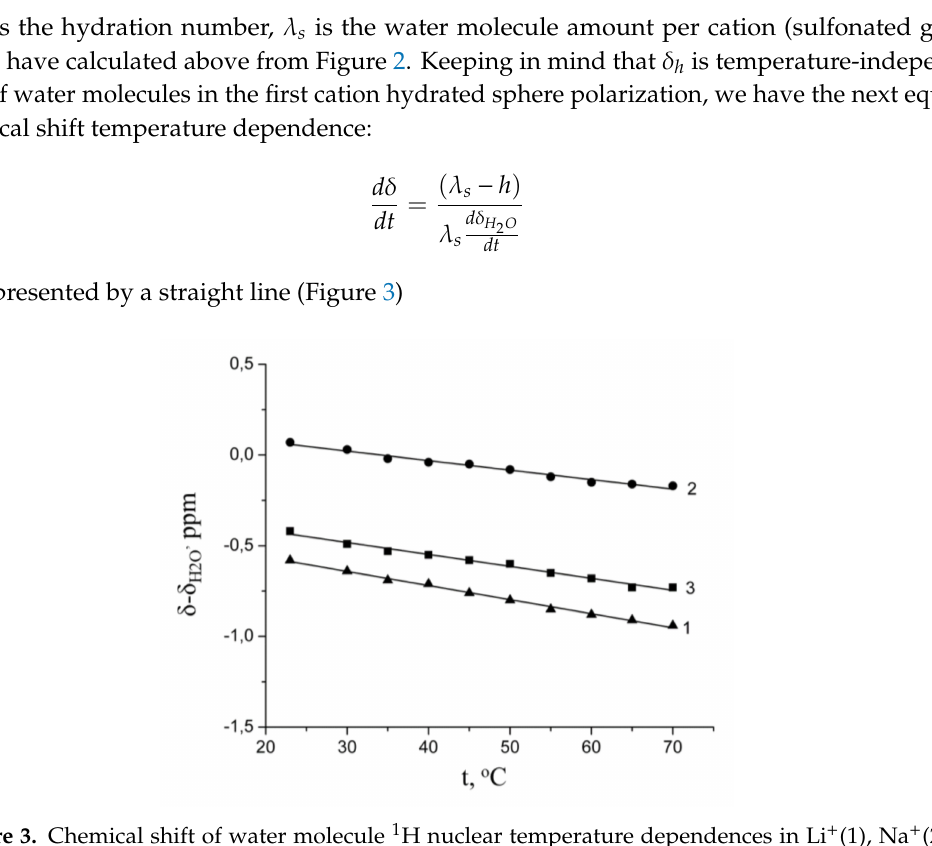
Figure 3. Chemical shift of water molecule 1 H nuclear temperature dependences in Li + (1), Na + (2) Cs + (3) ionic forms at RH =